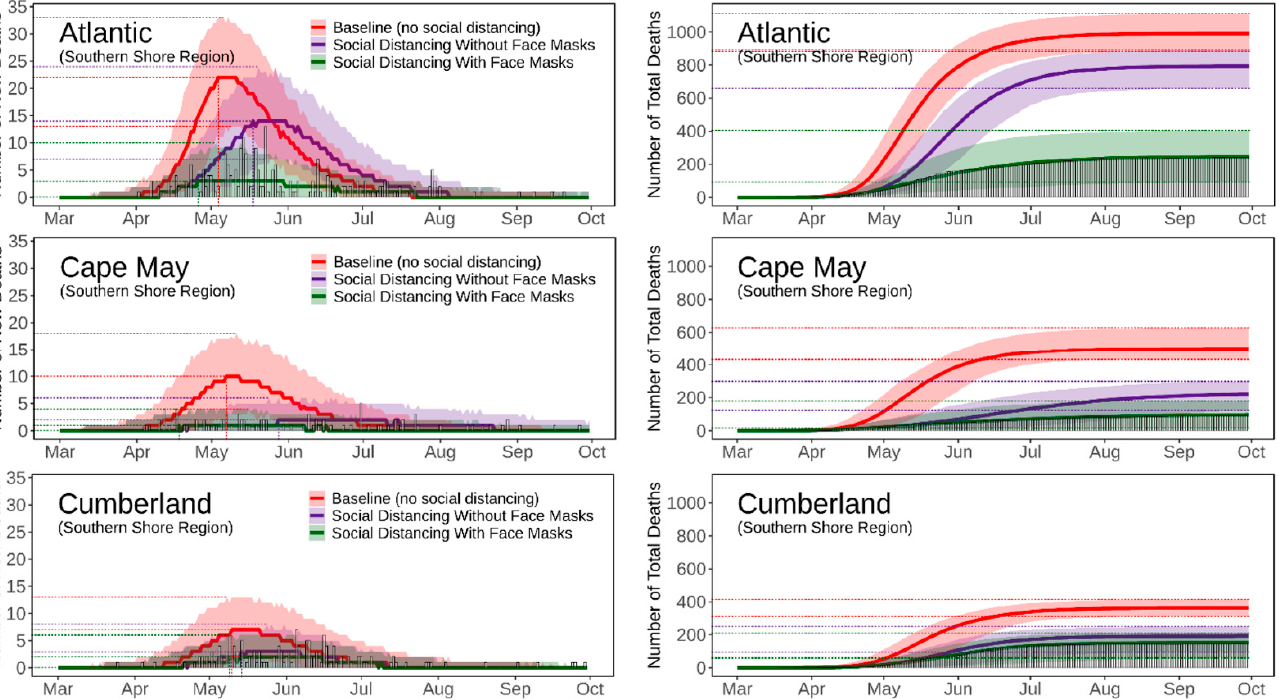
Figure 6. Predicted trajectories of new/total confirmed deaths from COVID-19 corresponding to three exposure scenarios for the counties in the Southern Shore Region of NJ, March to September 2020, compared with reported death data (vertical bars). The color-shaded areas depict the 95% Confidence Interval (CI) of the corresponding predictions. Three statistical measures, i.e., root mean squared error (RMSE), mean absolute per- centage error (MEPE), and envelope bias (EB), were used to evaluate model performance (Table S3). There is very good agreement between the predicted and reported numbers of total deaths. The reported total confirmed deaths are all within the 95% confidence interval for each county (except for Mercer with EB = 1 day), with MAPE ranging from 9% to 24%. The reported daily new deaths show inter-day fluctuations that, as expected, cannot be captured by the averaged estimates of the model, but most of which are within the 95% confidence interval. The RMSE of the daily new deaths varies for different regions,